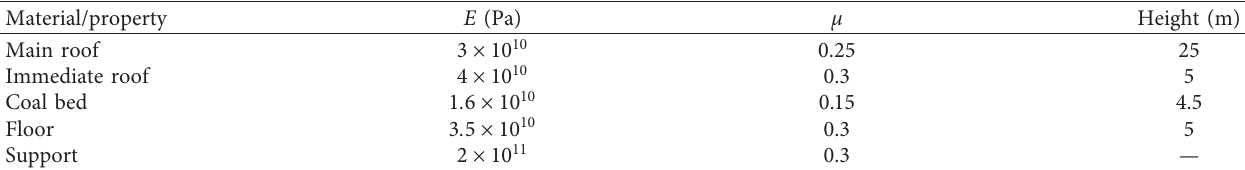
Table 1: Material parameters.